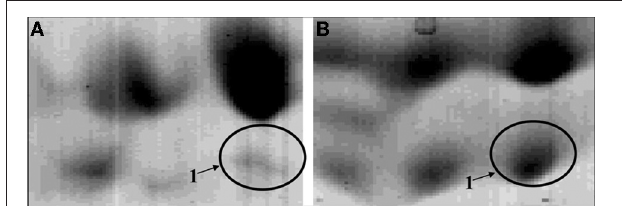
FIGURE 2 | Zoom of the proteomic maps of the membrane-enriched protein fraction of a tyramine and beta-phenylethylamineproducer Enterococcus faecalis grown in absence (A) or presence (B) of tyrosine. The circle indicated the enzyme TDC (tyrosine/phenylalanine